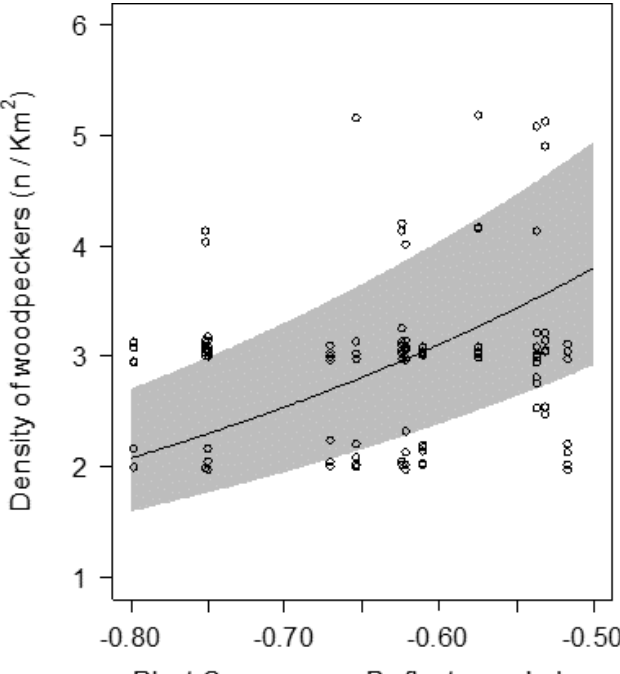
Fig. 2 . Bayesian estimates (points) for the density of Magellanic Woodpeckers ( Campephilus magellanicus ) as a function of Plant Senescence Reflectance Index. The exponential line and its confidence intervals are predicted from N-mixture Bayesian